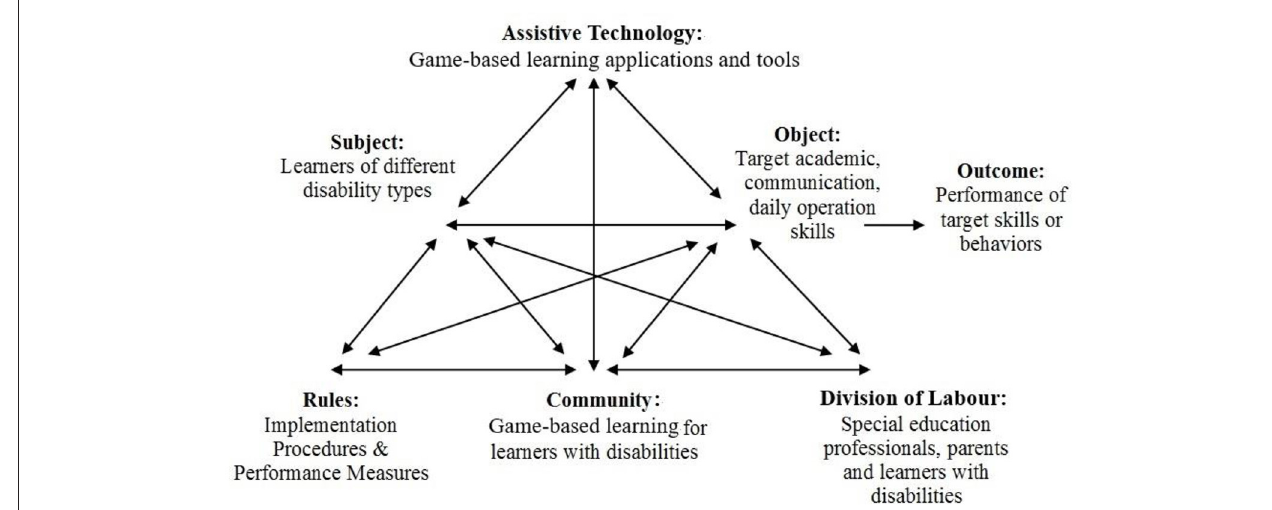
FIGURE 2 | Using activity theory to analyse studies on game-based learning for learners with disabilities.